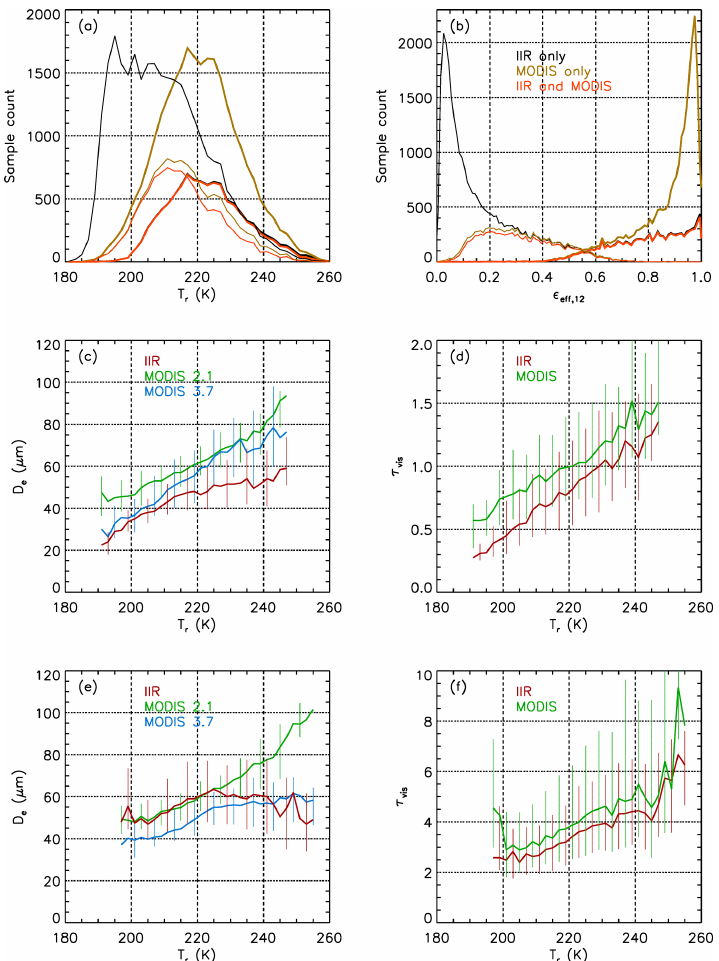
Figure 12. IIR and MODIS comparisons over oceans between 30 ◦ S and 30 ◦ N in January 2008 for single-layered high-confidence ROI clouds with MODIS ice phase. Distributions of (a) IIR radiative temperature and (b) IIR effective emissivity at 12.05µm in ST (thin lines) and opaque (thick lines) clouds where IIR has confident retrievals (black), MODIS has successful retrievals at 2.1 and 3.7µm (brown), and both IIR and MODIS retrievals are successful and can be compared (orange). Median D e vs. T r from IIR (red), MODIS 2.1 (green) and MODIS 3.7 (blue) in ST (c) and opaque (e) clouds; median τ vis from IIR (red) and MODIS (green) in ST (d) and opaque (f) clouds. The vertical bars in panels (c–f) are between the 25th and 75th